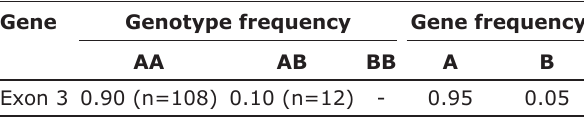
SSCP=Single strand conformation polymorphism